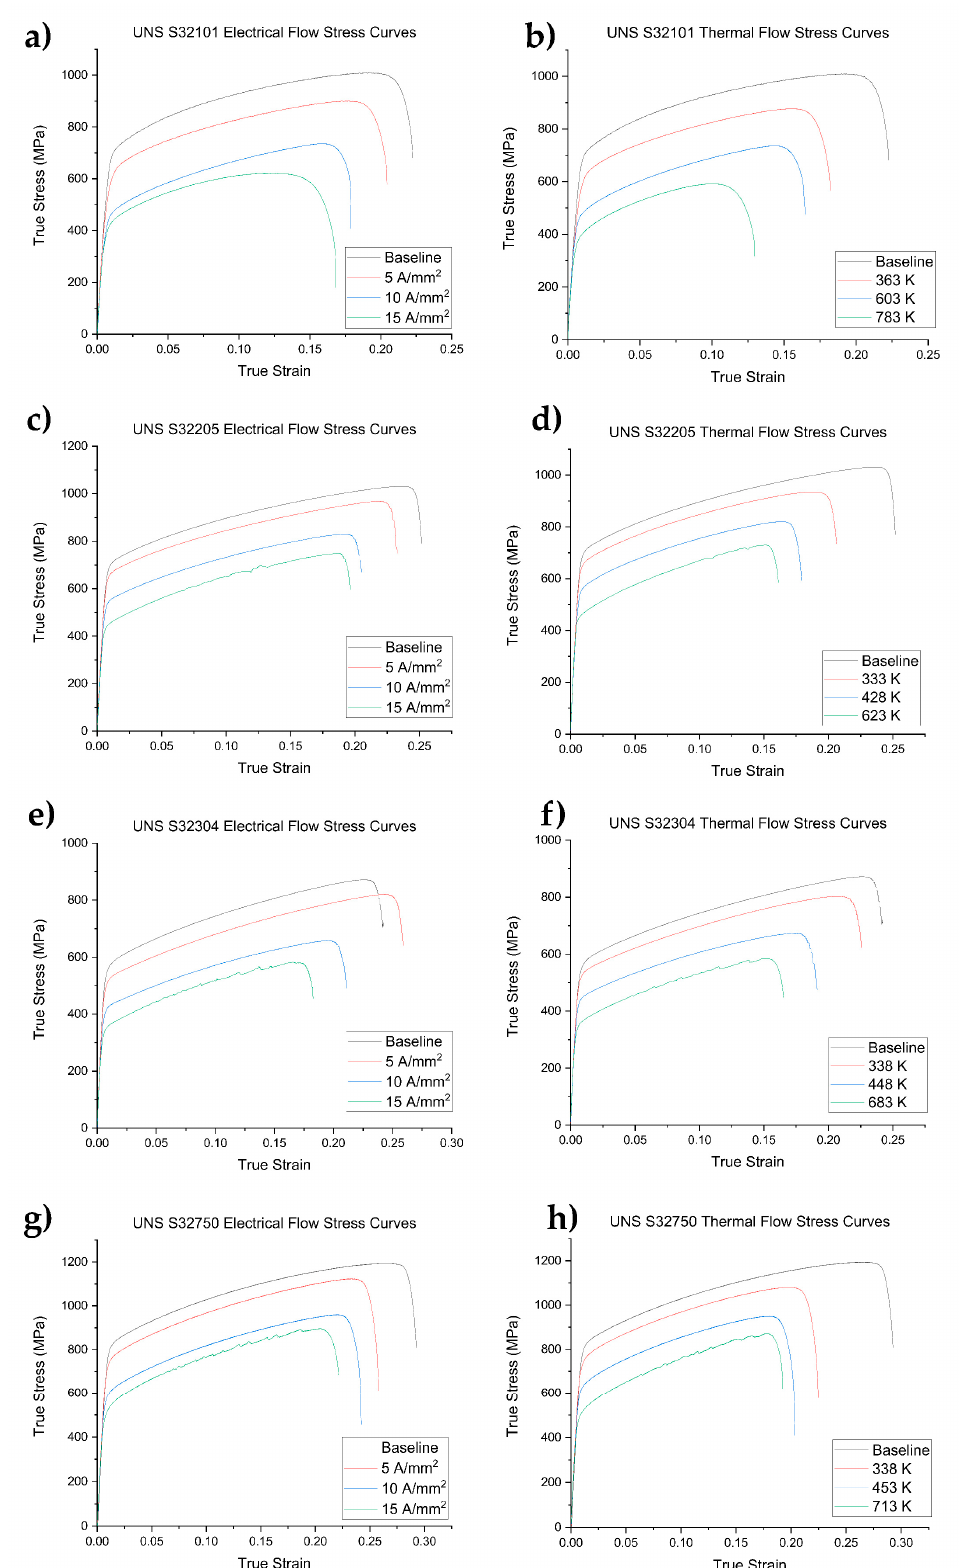
Figure 8. True stress-strain curves of electrical current tests on the left side and the related thermal counterpart on the right side for the different DSS grades: UNS S32101 ( a , b ); UNS S32205 ( c , d ); UNS S32304 ( e , f ); and UNS S32750 ( g , h ).